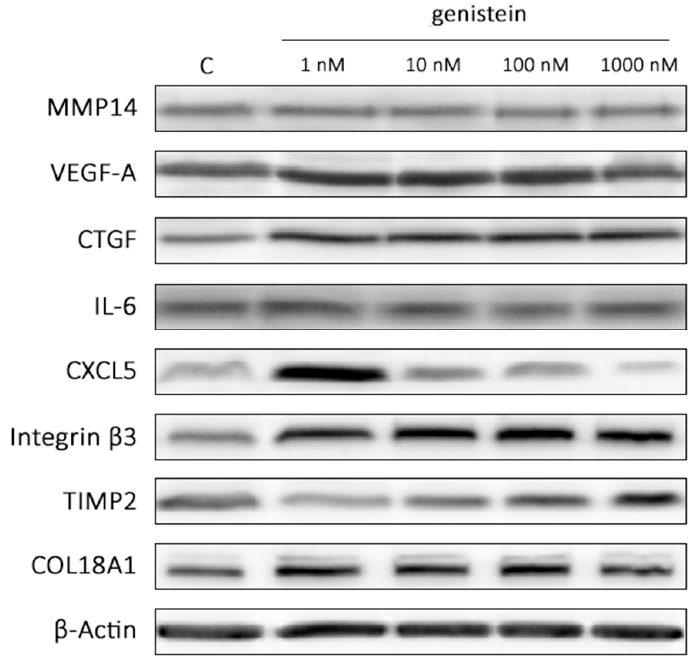
Figure 3. Western blot analysis of selected proteins performed on human microvascular endothelial cells (HMVEC-d) co-treated with VEGF (25 ng/mL) and increasing concentrations of genistein (1–1000 nM) after 48 h of incubation (MMP14—matrix metalloproteinase 14; VEGF-A—vascular endothelial growth factor A; CTGF—connective tissue growth factor; CXCL5—C-X-C motif chemokine 5; IL-6—interleukin 6; ITGB3—integrin β 3; COL18A1—Collagen Type XVIII